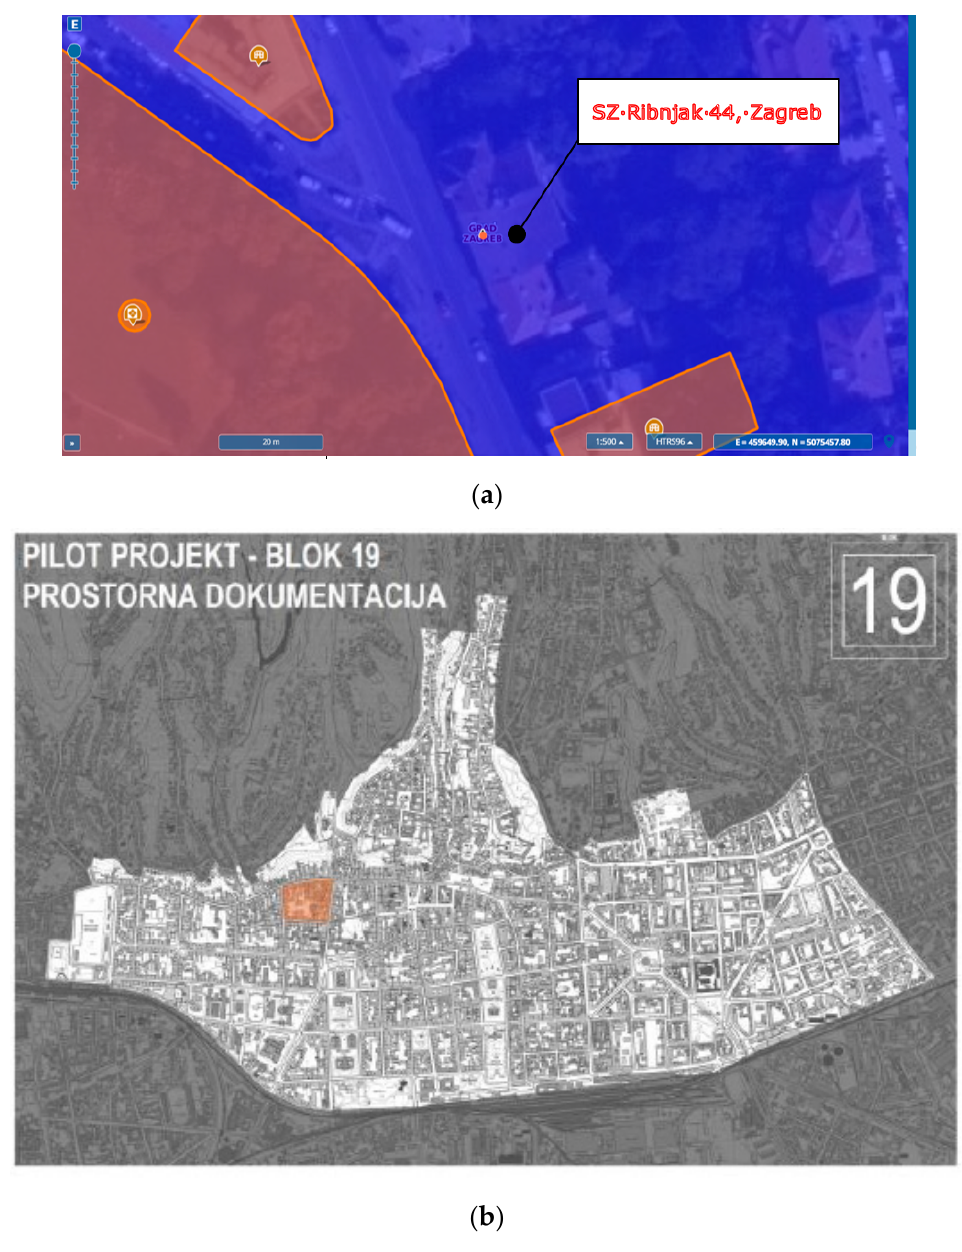
Figure 3. ( a ) Location of the elaborated building—Zone A; ( b ) register of cultural assets-damages